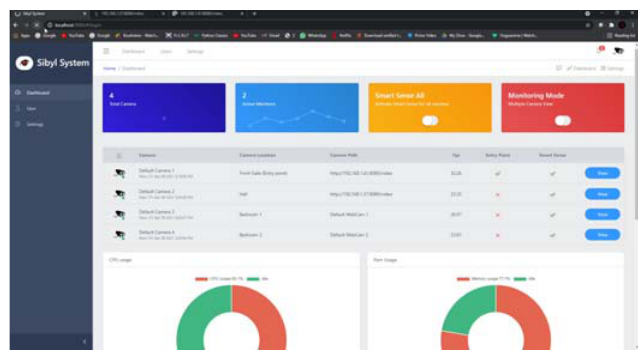
Fig15: Initial Setup screen